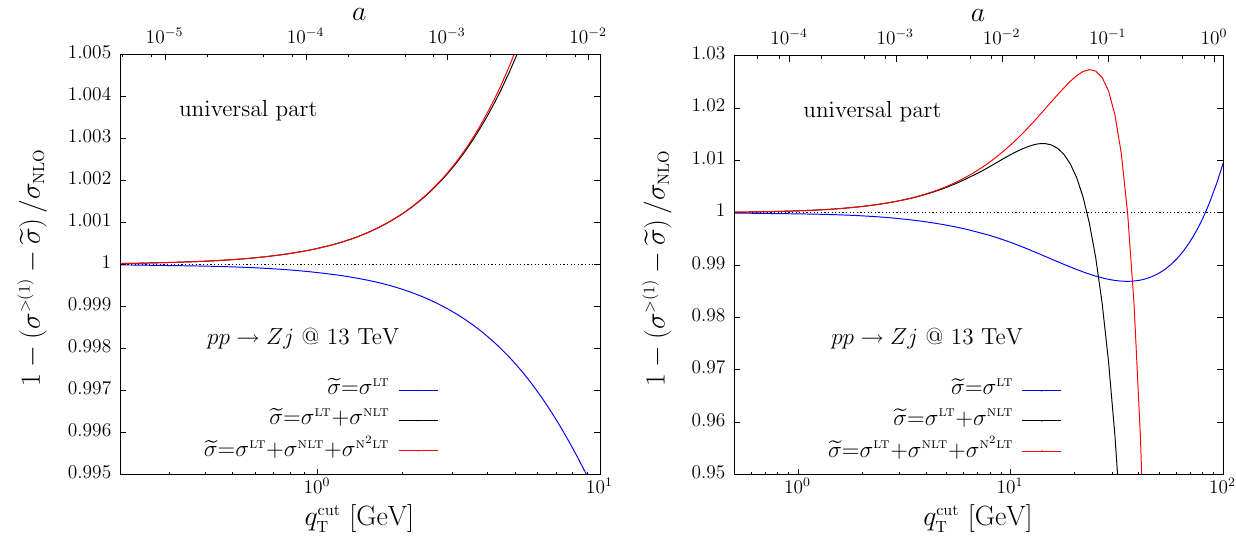
( z ) in computing the cross sections of Eqs. ab